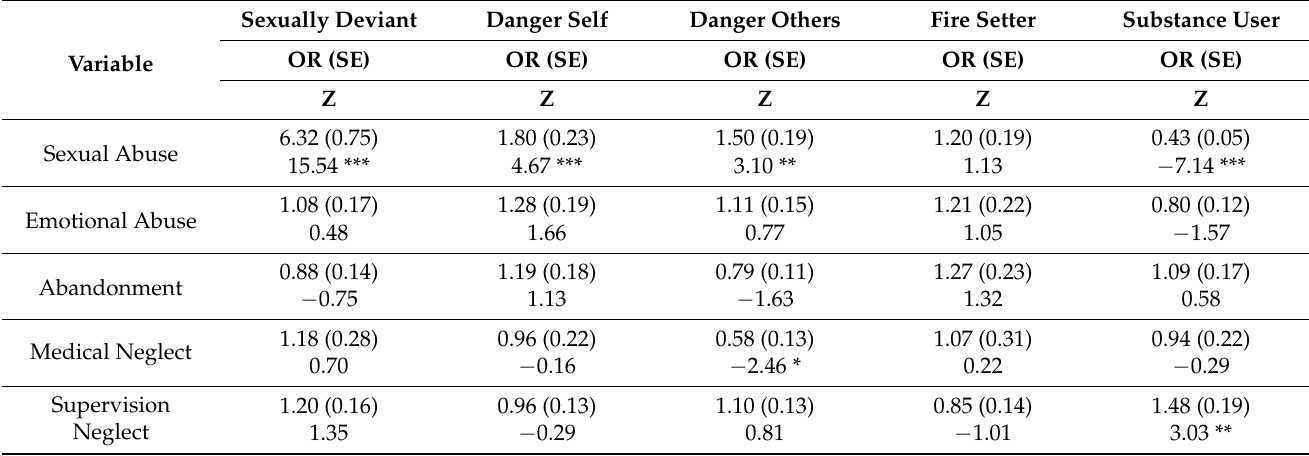
Table 3. Logistic Regression Models for Forensic Typologies for Individual ACEs without